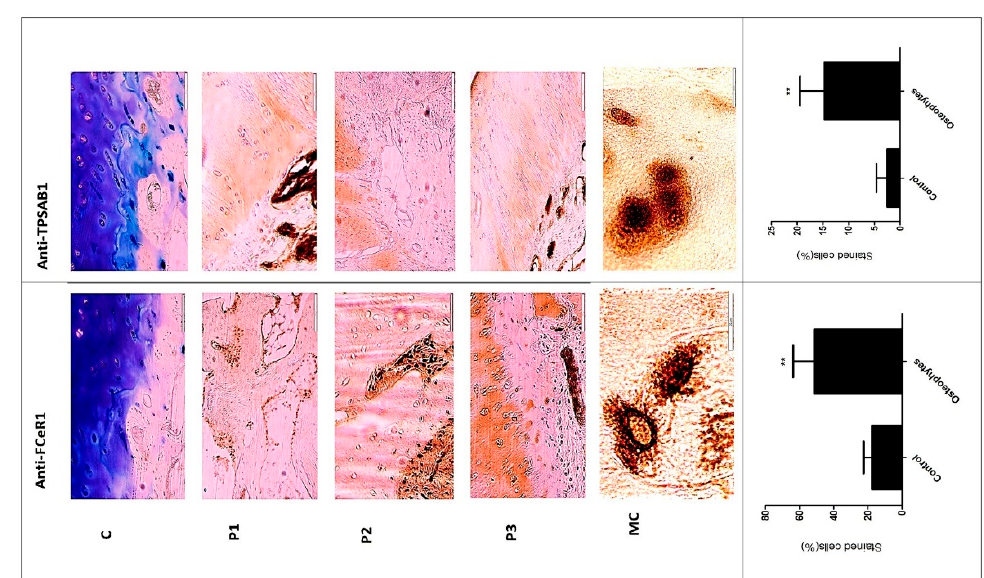
Figure 4. Representative slides of IHC staining with anti-FCERI and anti-TPSAB1 to visualize mast cells in osteophyte sections. Representative areas of osteophytes of study patients are shown as P1, P2 and P3. Antibody-stained mast cells were localized in bone trabeculae, cartilage region, where the columnar chondrocytes can be seen. MC are mast cells at 100X magnification revealing granular features. Bottom panel: histograms—control and osteophytes, denote anti-FCERI and anti-TPSAB1 stained cells (%) respectively; * p < 0.05, ** p < 0.01 compared to control.